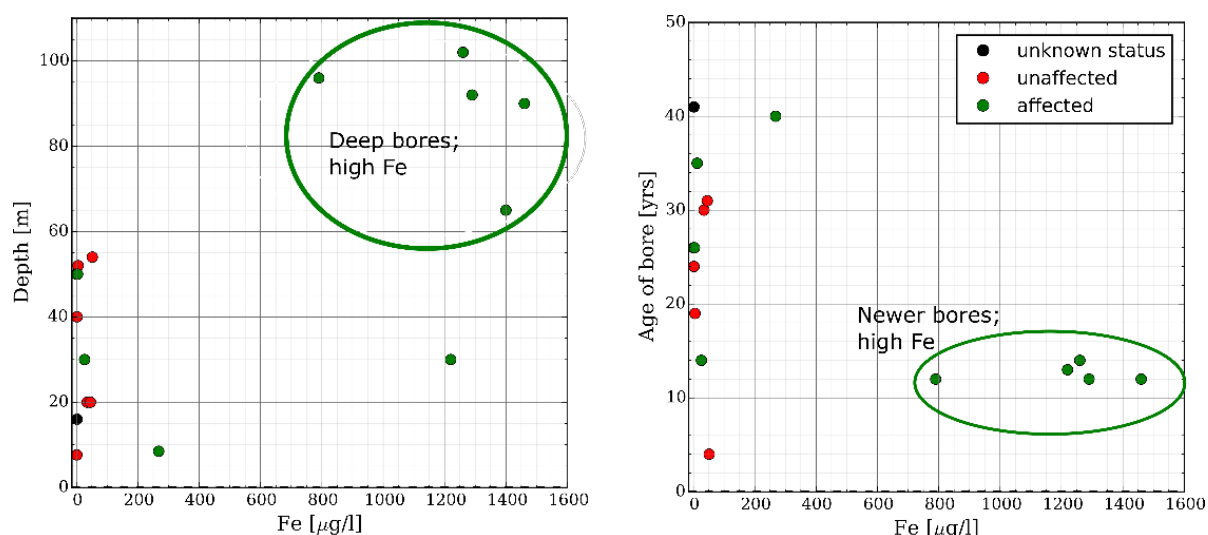
Figure 6. Correlation between the depth of bores and Fe(II) and Mn(II) concentrations as well as borehole age. Information on depth and/or age was not available for all sampled bores.